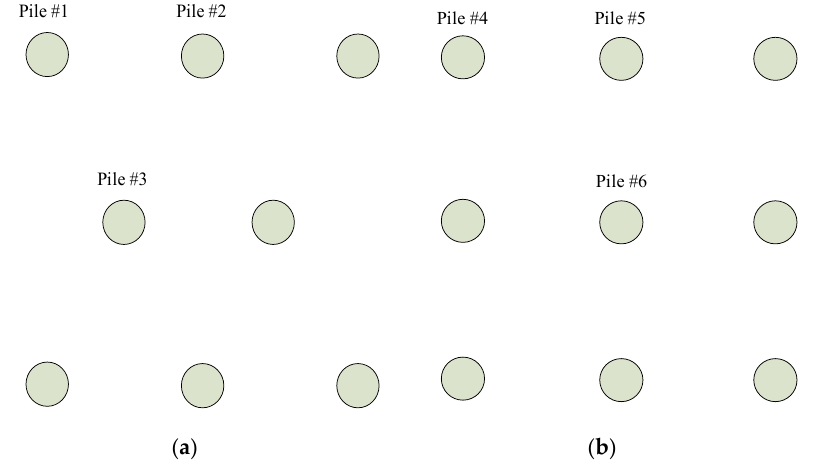
Figure 6. The pile number designation in ( a ) quincuncial arrangement, ( b ) squared arrangement.